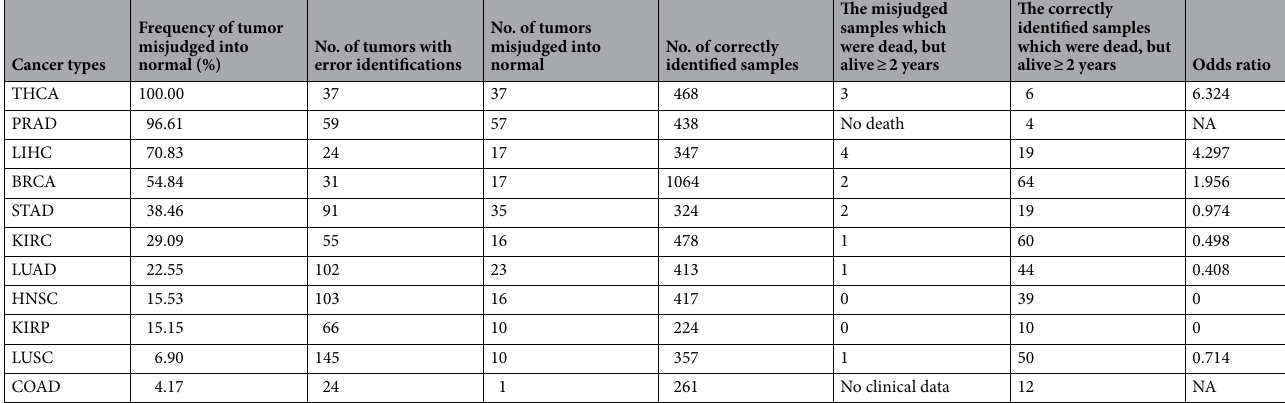
Table 2. The association between the number of misjudgments between tumors and normal samples and survival time. NA not